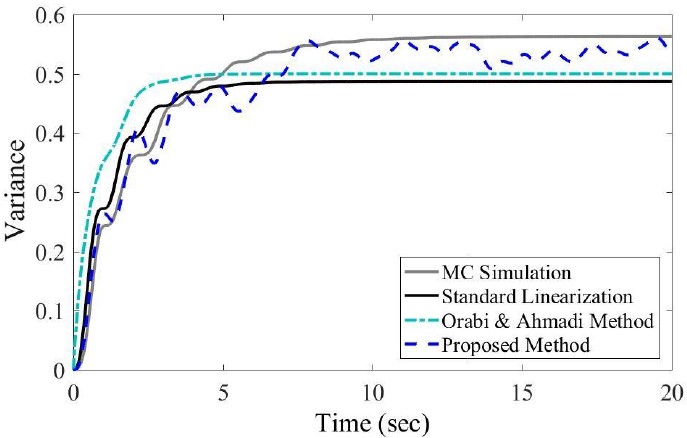
Figure 3. Mean square displacement response due to stationary excitation. ( γ = 1.0, μ = 10.0).